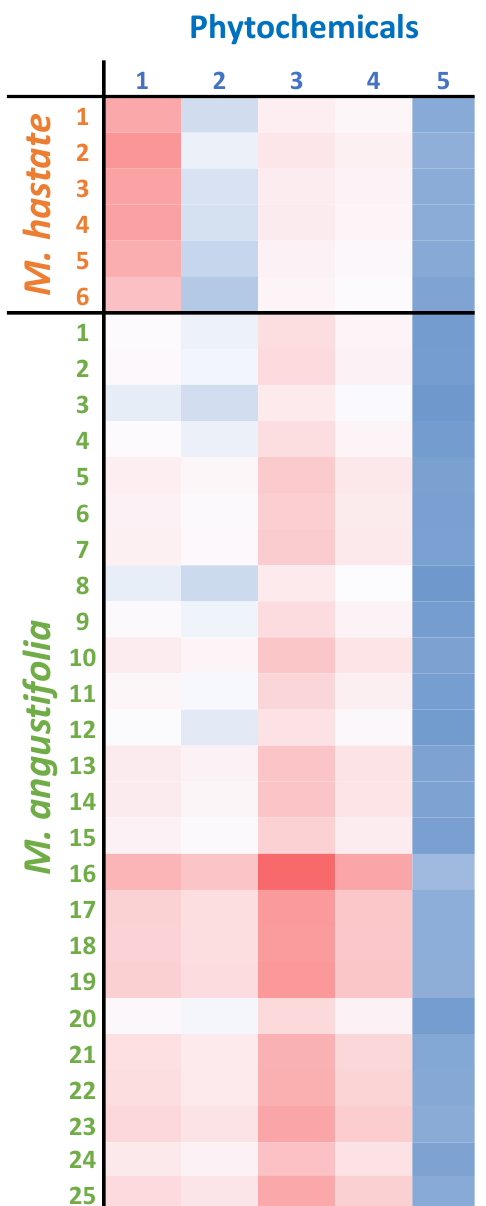
Figure 5. Absolute quantification of the main flavonoids in different populations of two Monochoria species (6 populations of M. hastata and 25 populations of M. angustifolia ) covering the entire floristic regions from Thailand. 1. apigenin-7- O -rutinoside; 2. luteolin-7- O -glucoside; 3. apigenin-7- O - glucoside (also known as apigetrin); 4. luteolin; 5. apigenin. Means and standard deviations are provided in Table S1.